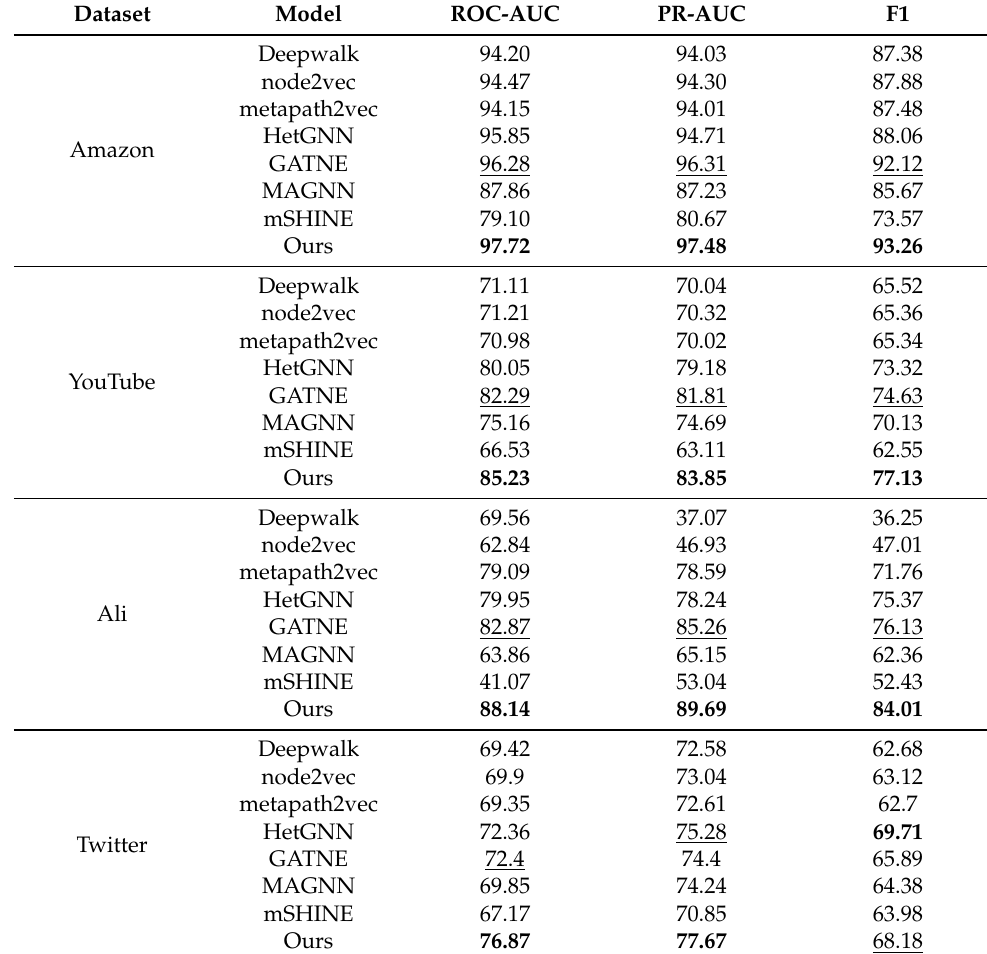
Table 3. Performance comparison of different models on four datasets. The optimal performance and the suboptimal performance are denoted in bold and underlined fonts